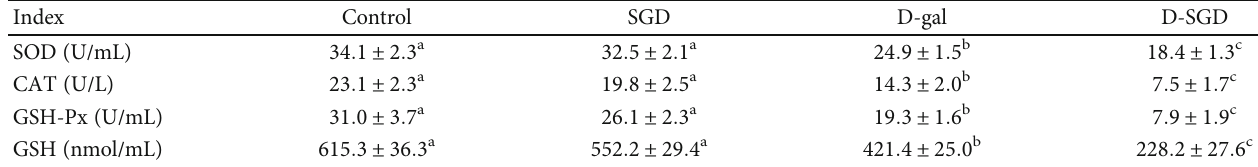
Table 3: E ff ects of serine de fi ciency on activities of antioxidant enzymes and GSH concentration in the serum of D-galactose-induced aging